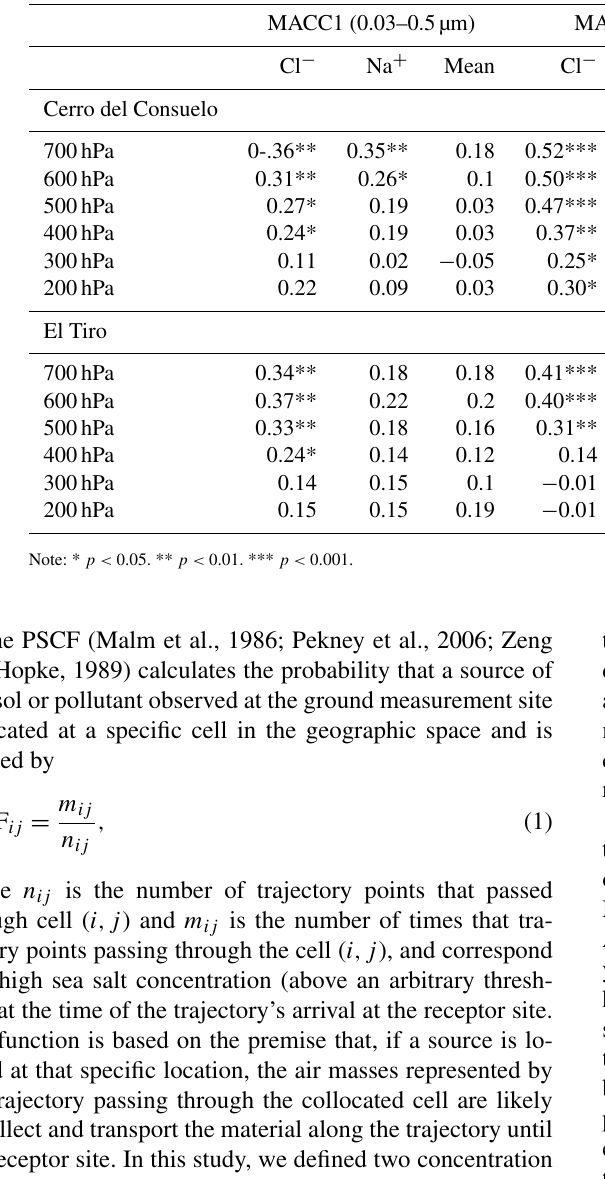
Table 1. Results from the correlation analysis between sea salt monthly mean concentration from the MACC reanalysis data and Na + and Cl − monthly mean concentration samples from El Tiro and Cerro del Consuelo meteorological stations. Correlations were tested for the various elevations within the MACC data